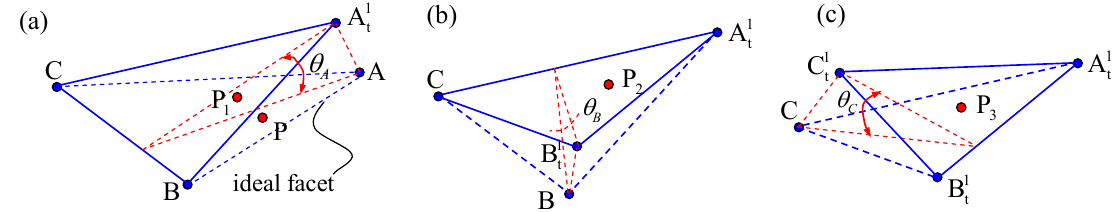
Figure 4. The three rotational motions of the mirror unit in order ABC consist of: ( a ) rotation about axis CB, ( b ) rotation about axis A 1 C, and ( c ) rotation about axis B 1 A 1 t t t